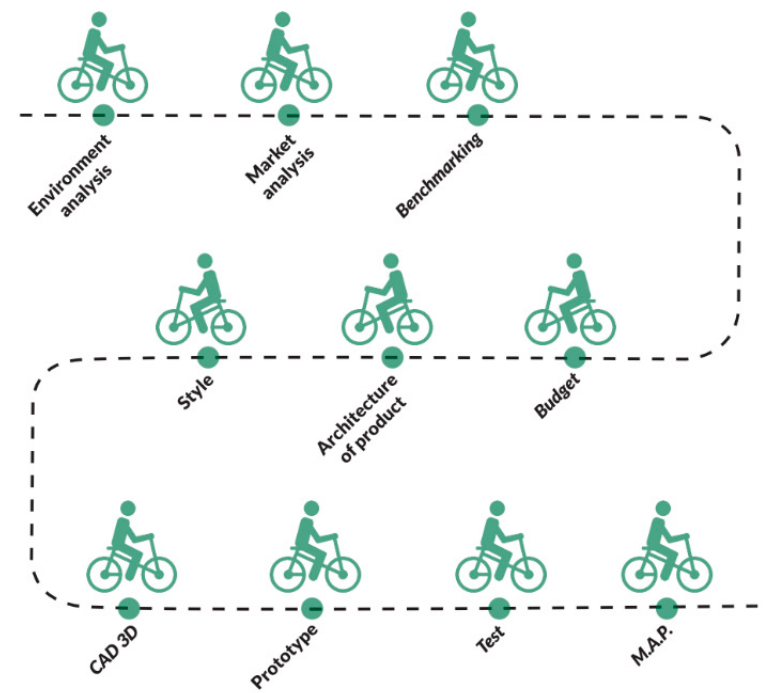
Figure 1. The road map of the industrial design structure (IDeS) project.